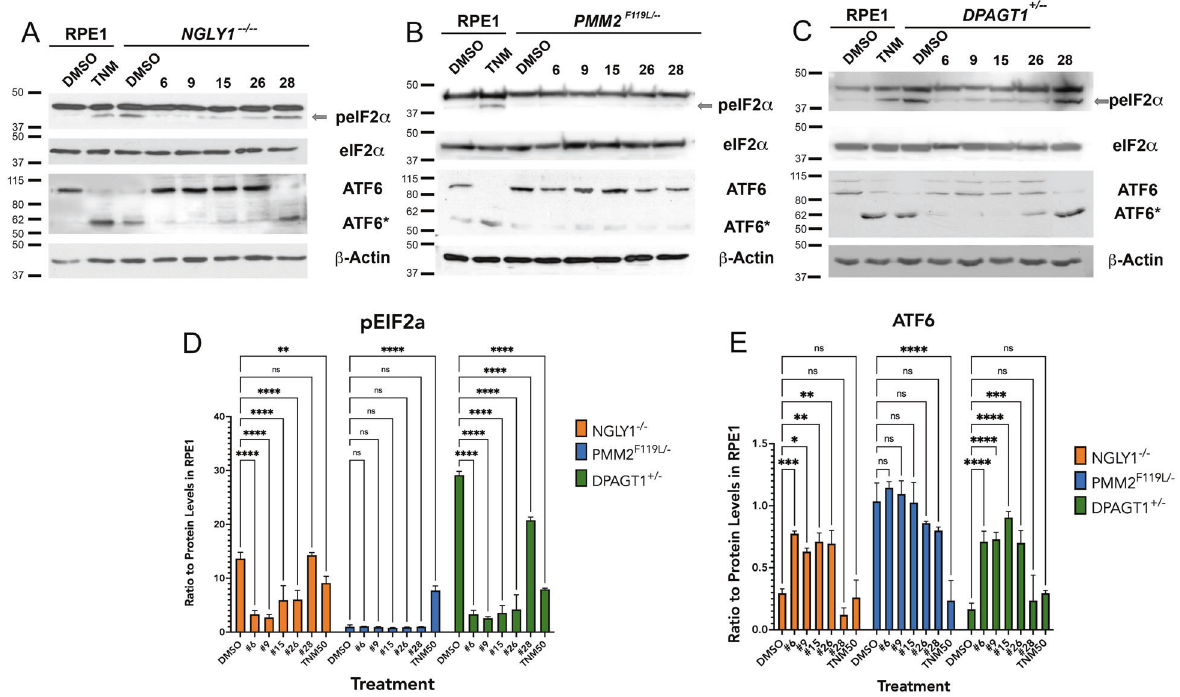
Fig. 7 Select candidate compounds are able to alleviate the multiple ER stress phenotypes identi fi ed in each of the CDG and CDDG lines. Following treatment of CDG and CDDG cell lines with optimized concentrations of candidate compounds (6, 9, 15, 26) and a non-active control compound (28), p-eIF2 α and ATF6 levels were assessed by immunoblot. A – C Representative images of immunoblots. TNM, tunicamycin (50 nM). ( D , E ) Quanti fi cation of p-eIF2 α levels in levels in CDG/CDDG treated cells. ( n = 3 per each genotype and treatment). Expression data in ( D , E ) are relative to expression levels in parental RPE-1 cells. ns, not signi fi cant. * P < 0.05, ** P < 0.01, *** P < 0.001, *** P < 0.001 by one-way ANOVA followed by Dunnett multiple comparisons Table 1 provides a summary of correction for proliferation and ER stress markers for each compound tested in each of the CDG and CDDG lines. Taken together, our screen identi fi ed several highly-effective lead compounds that are able to correct proliferation defects as well as alleviate molecular markers of multiple ER stress pathways dysregulated in cellular models of CDG and CDDG.